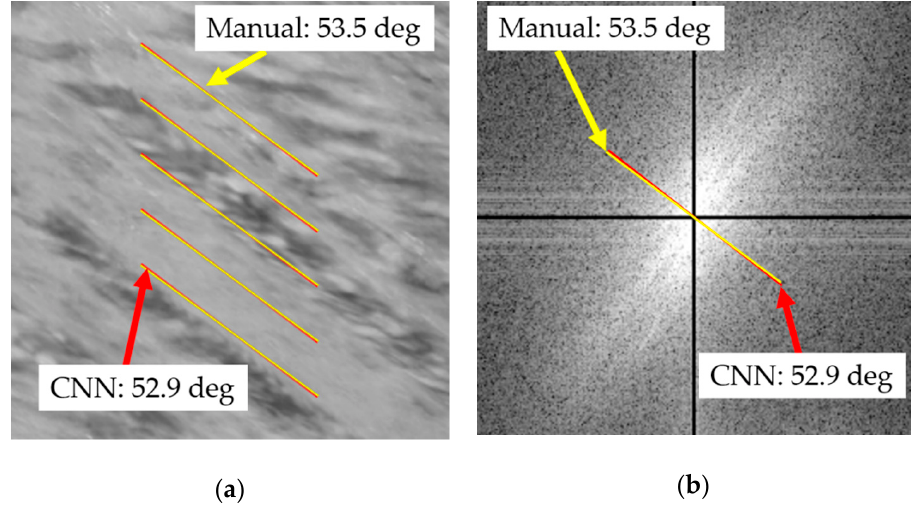
Figure 17. Additional training data collected from real river videos. ”Truth” labels indicate correct (ground truth) angles